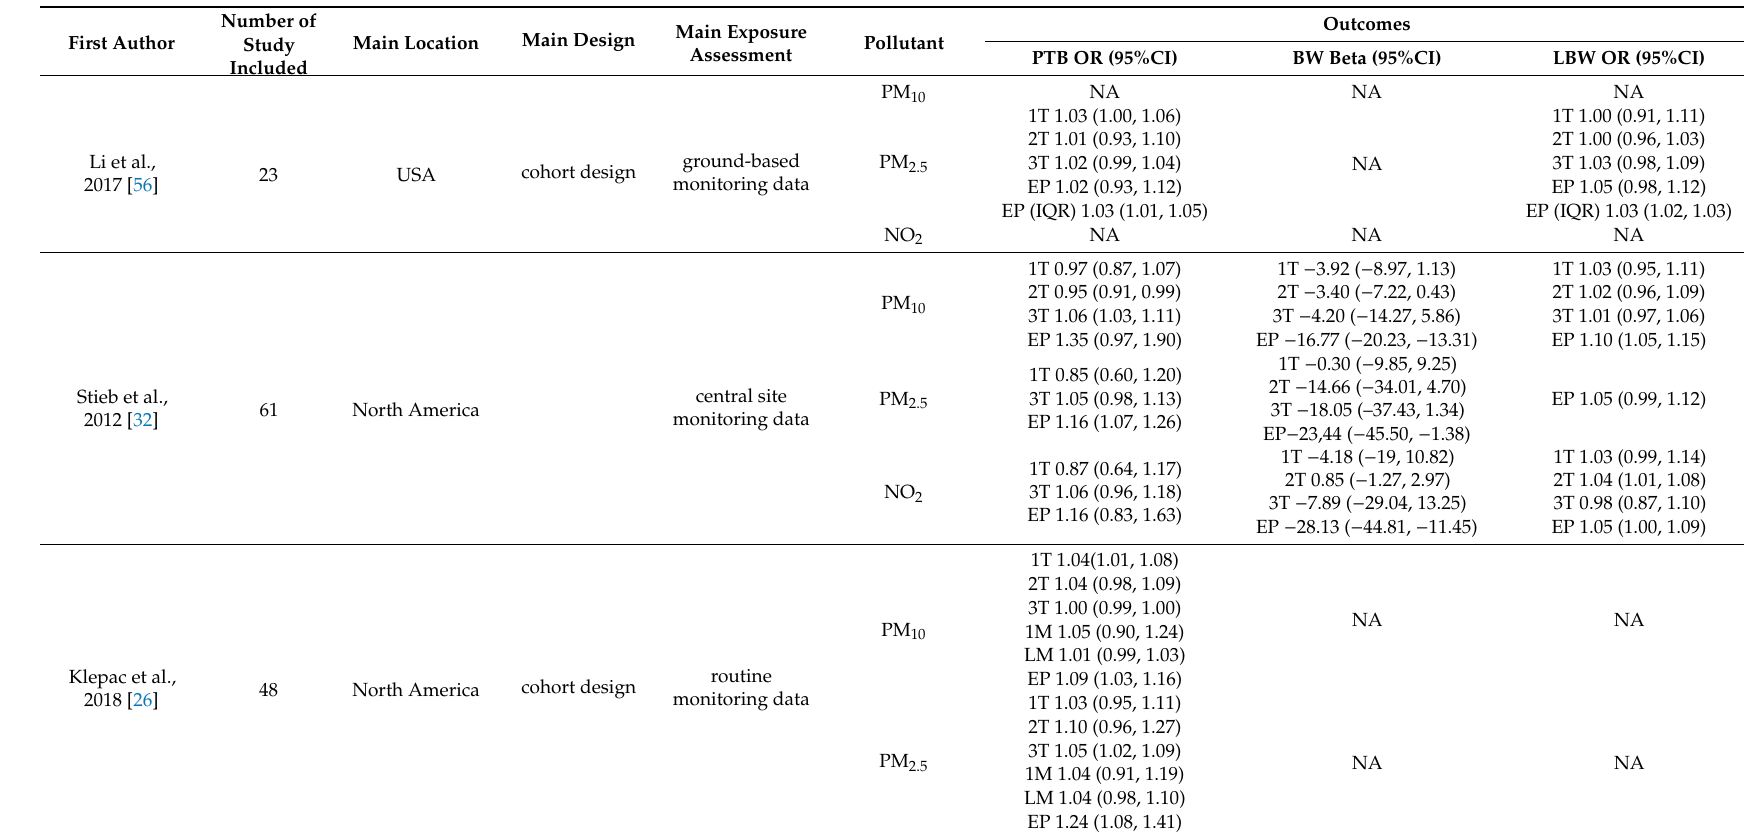
Table A5. Meta-analysis